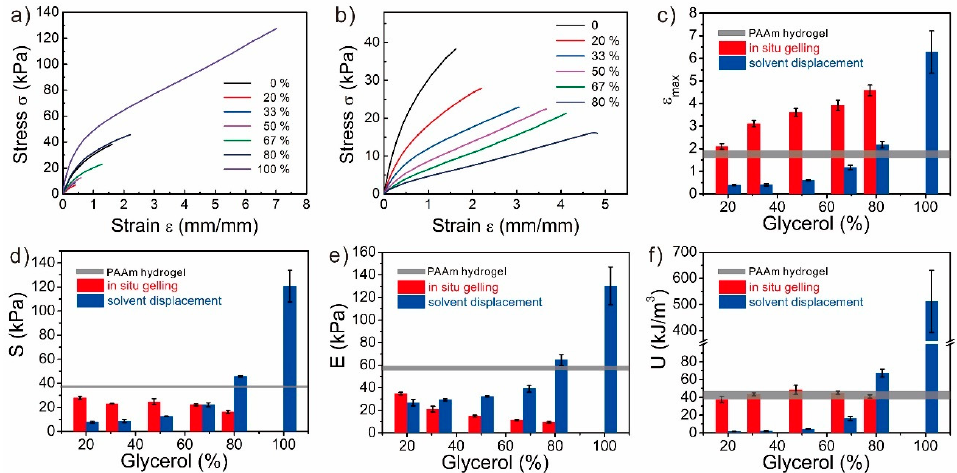
Figure 2. Mechanical properties of the PAAm gels with various glycerol contents from both synthesis strategies. ( a , b ) Stress-strain curves of the PAAm gels with various glycerol contents from ( a ) in-situ gelling and ( b ) solvent displacement. ( c ) Tensile strain, ( d ) tensile stress, ( e ) elastic modulus, and ( f ) toughness of the PAAm gels as the functions of the glycerol content in PAAm gels. The horizontal grey lines ( c – f ) indicate the data from PAAm hydrogels, and the width of the line represents the error range.